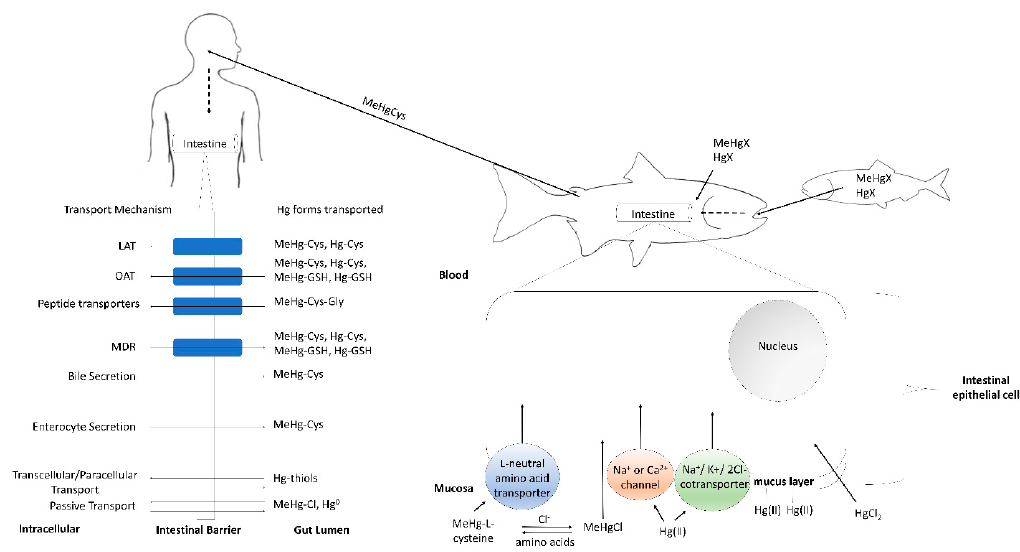
Figure 1. Model for methylmercury (MeHg) and inorganic mercury (Hg(II)) uptake across fish and human